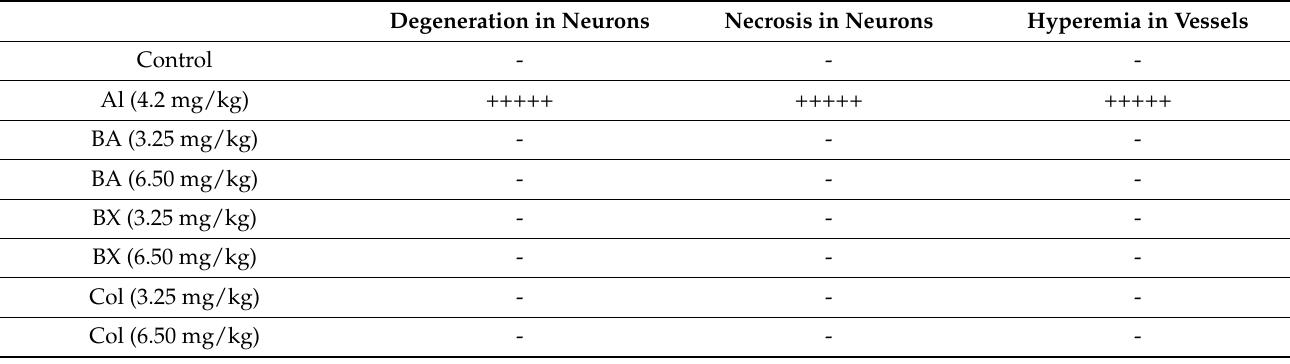
Table 6. Scoring of histopathological findings observed in the hippocampus after treatments with boron compounds and Al. (- nonsignificant; + significant at %0.01; ++ significant at %0.1; +++